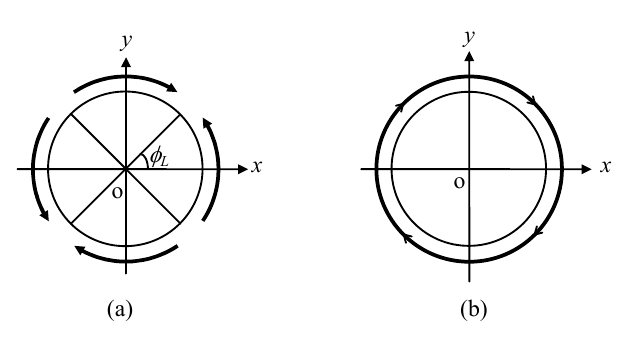
Fig.10 Effect of shear flow on the director